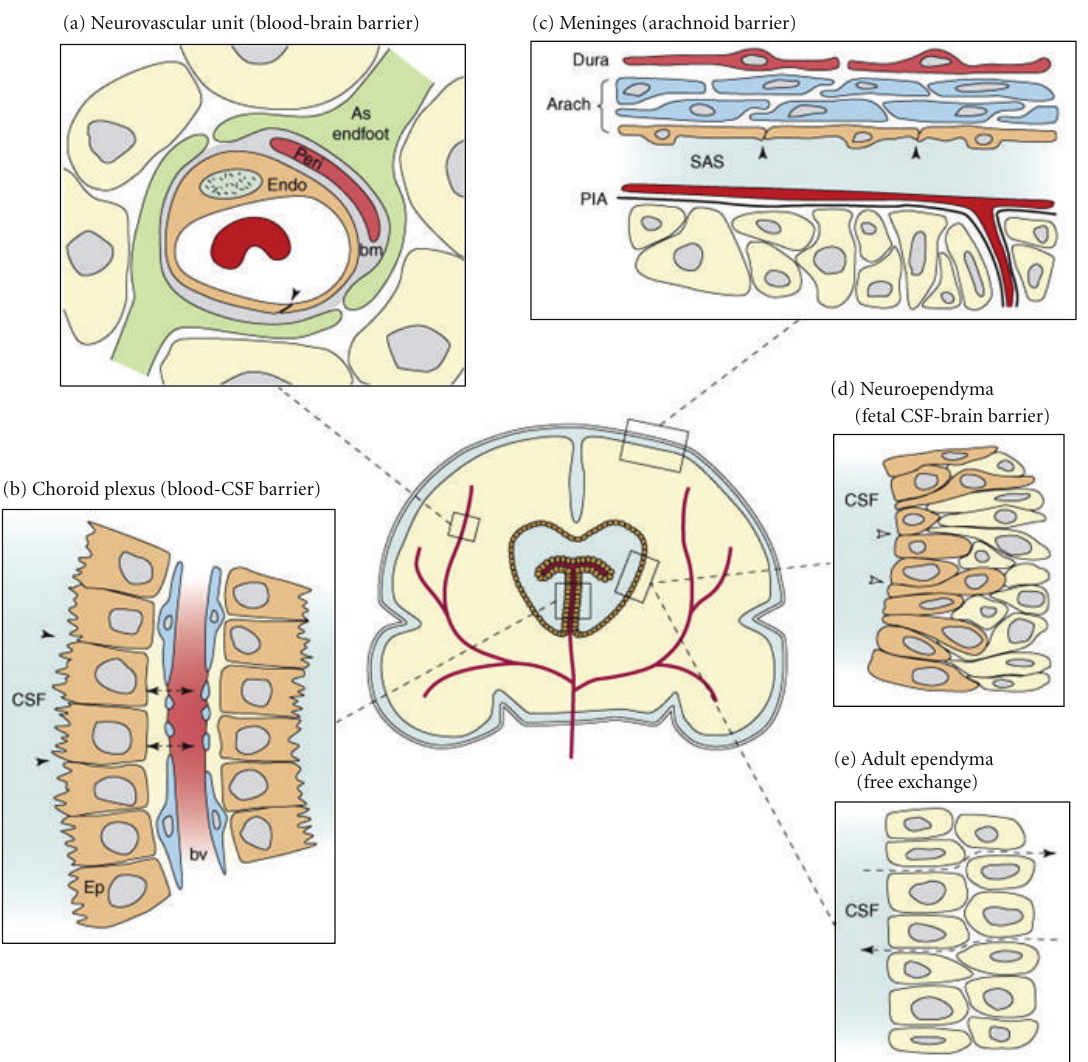
Figure 2: Barrier interfaces in brain. (a) endothelial cells (endo) in the neurovascular unit have luminal tight junctions (shown by the arrow) that form the physical barrier of the interendothelial cleft. Outside the endothelial cell is a basement membrane (bm) which also surrounds the pericytes (Peri). Around all of these structures are the astrocytic end-feet processes from nearby astrocytes. (b) The endothelial cells of choroid plexus blood vessels are fenestrated and form a nonrestrictive barrier (shown by dashed arrows) between the cerebrospinal fluid (CSF) and blood vessel (bv). The epithelial cells (ep) have apical tight junctions (shown by arrows) that restrict intercellular passage of molecules. (c) In the meninges, the blood vessels of the dura are fenestrated and provide little barrier function (not shown). However, the outer cells of the arachnoid membrane (Arach) have tight junctions (shown by arrows), and this cell layer forms the physical barrier between the CSF-filled subarachnoid space (SAS) and overlying structures. The blood vessels between the arachnoid membrane and the pial surface (PiA) have tight junctions (not shown). (d) In early development, the neuroependymal cells are connected to each other by strap junctions (shown by arrows) that are believed to form the physical barrier restricting the passage of larger molecules, such as proteins, but not smaller molecules, such as sucrose. (e) The mature adult ventricular ependyma does not restrict the exchange of molecules (shown by dotted arrows). The neurovascular unit (a), blood-CSF barrier (b), and arachnoid barrier (c) are common between developing and adult brain, whereas fetal neuroependyma (d) di ff ers from adult ependyma (e) (cited from [19] with permission from cell